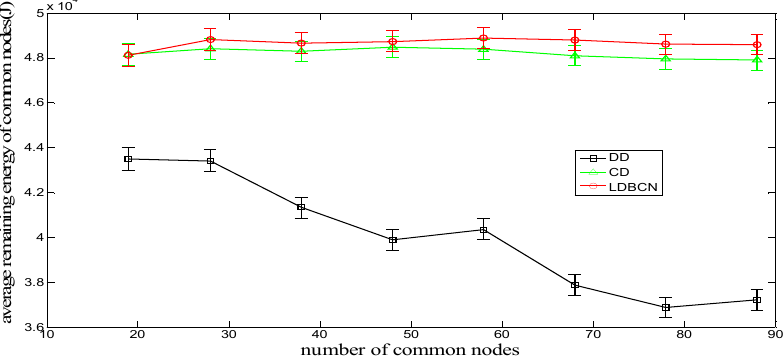
Figure 9. Average remaining energy of common nodes for dispatch algorithms.